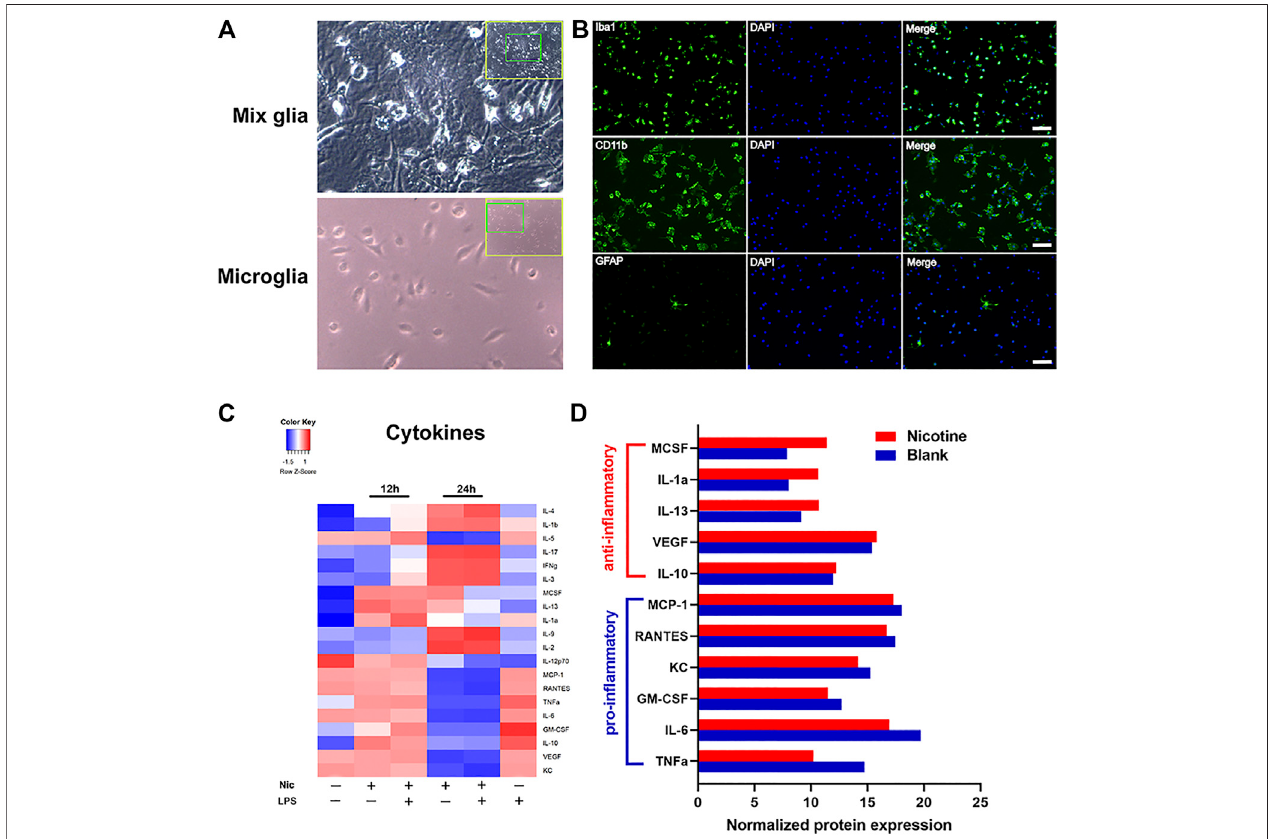
FIGURE 4 | Nicotine exposure suppressed in fl ammatory cytokine revealed by protein array. Primary microglia were isolated from postnatal day 2 – 4 mouse brain (A) and were identi fi ed by immuno fl uorescent staining with Iba1, CD11b, and GFAP antibody. Puri fi ed microglia were shown in (B) . GFAP positive astrocytes were found scarcely in the culture while the vast majority of cells were positive for Iba1 and CD11b staining. Unstimulated primary microglia were served as blankforeachtimepoint.LPS(10 μ g/ml)-stimulatedcells(LPSgroup),nicotine(10 μ mol)-treatedcells(nicotinegroup),andLPS(10 μ g/ml)plusnicotine(10 μ mol)- treatedcells(LPSplusnicotinegroup)wereused.CellswerepretreatedwithLPS30 minbeforeaddingnicotine.MicrogliacellsincubatedwithLPSfor24 hwereusedas the pro-in fl ammatory control. Supernatant were collected at 12 and 24 h after treatment. Each group had duplicated wells. Pro-in fl ammatory and anti-in fl ammatory responses in microglia were evaluated by a commercial cytokine array. Cytokines expression levels were severally determined using a 20-array. Heat map representing cytokineconcentrationswasshown (C) .Quantitativeanalysisofcytokinessecretedfromprimarymicrogliawerepresentedinthegraph (D) .Eachgroupwasduplicated, and the mean of the respective cytokine is represented in the heat map and the bar